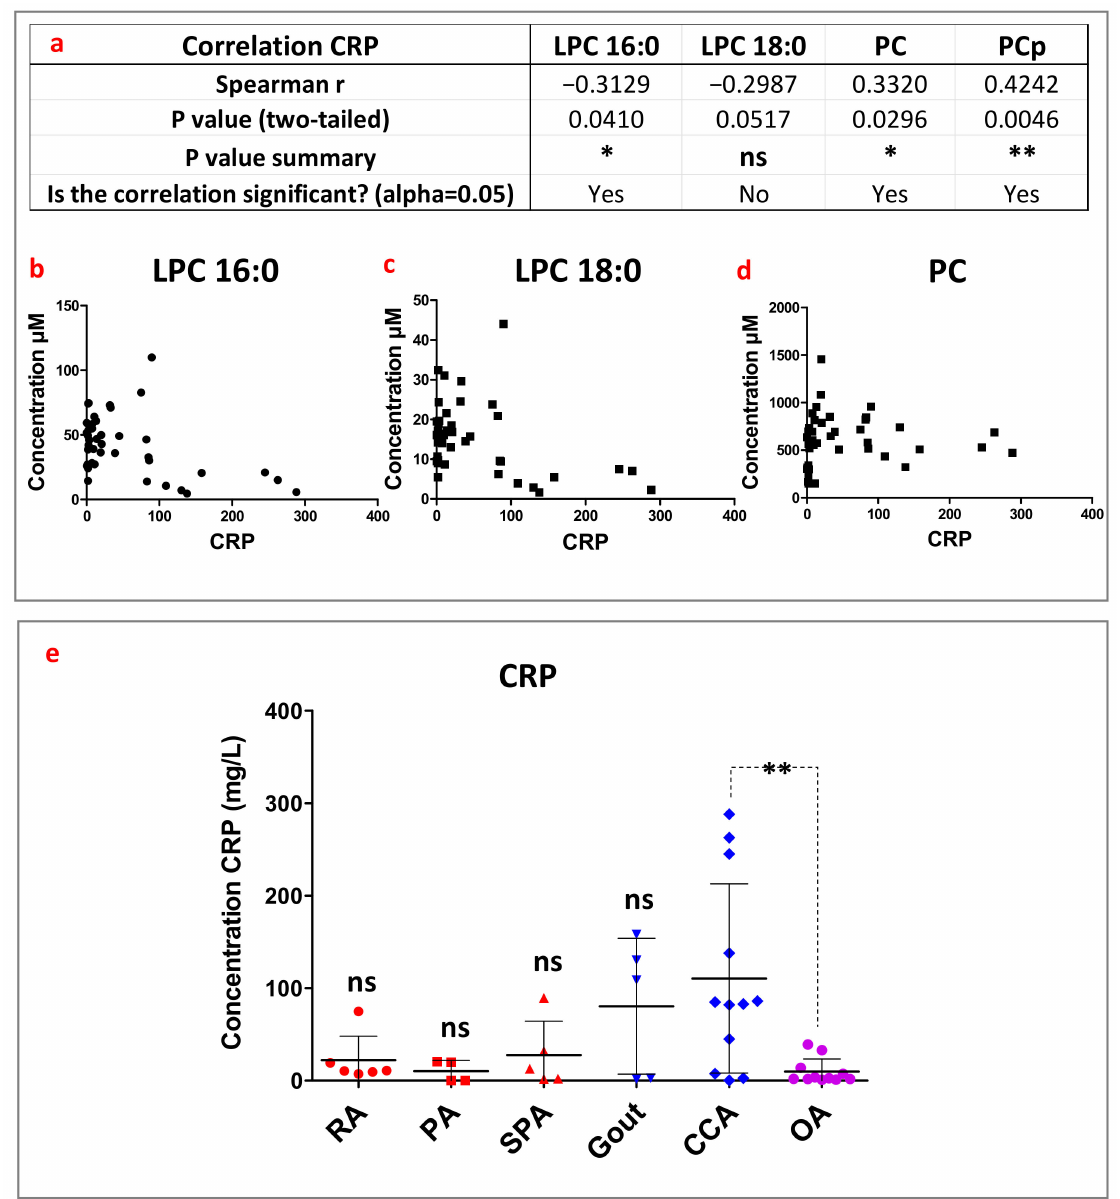
Figure 5. Lipid concentrations in the synovial fluid of patients according to the inflammatory state of the patients. Circulating C-Reactive Protein (CRP mg/l) was considered as an indicator of systemic inflammation. ( a ) Table of Spearman correlation results of circulating CRP with LPC16:0, LPC18:0, PC and PCp levels. ( b – d ), Correlation plots of CRP level with LPC16:0, LPC18:0, and PC levels, respectively. ( e ) Concentration (in mg/L) of circulating CRP according to the different joint diseases showing higher CRP levels in microcrystalline arthropathies patients. One-way analysis of variance completed with the Bonferroni’s Multiple Comparisons Test were performed to compare CRP concentrations in the individual joint pathologies; ns: not significant p > 0.05, *: 0.01 < p < 0.05, **: 0.001 < p <